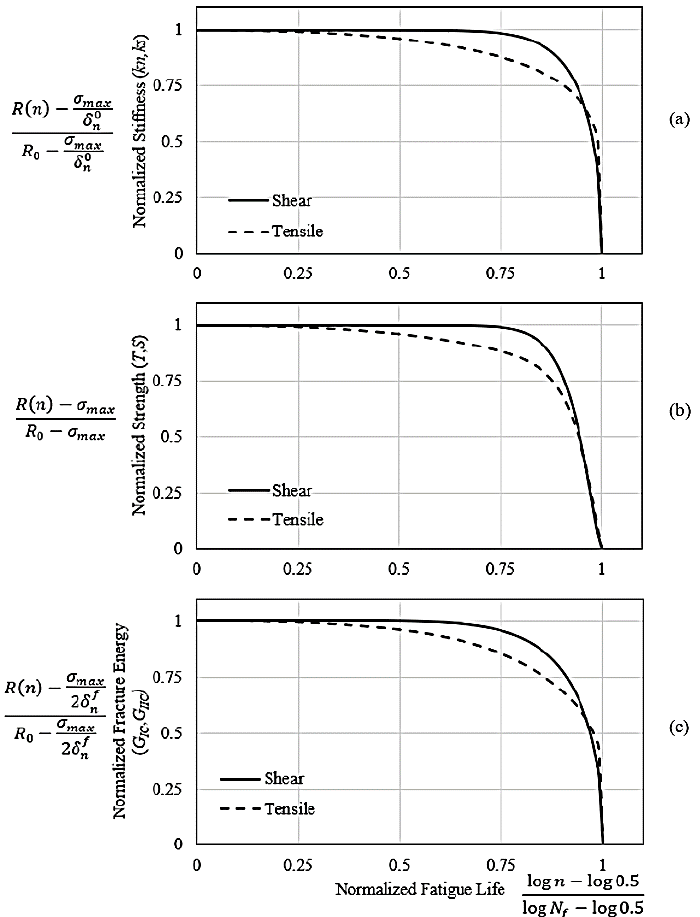
Figure 3. The normalized residual fatigue properties of the interface for ( a ) normal and shear penalty stiffness, ( b ) tensile and shear strength, and ( c ) fracture energy for mode I and mode II loading. Table 2. Normalized model parameters.